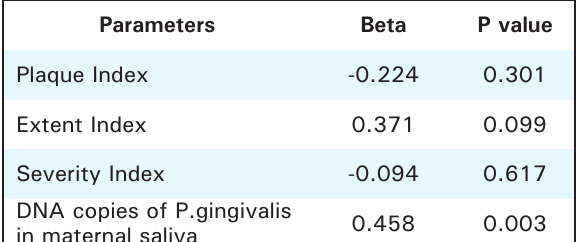
Table 5. Independent predictors of DNA copies of P.ginigvalis in child’s